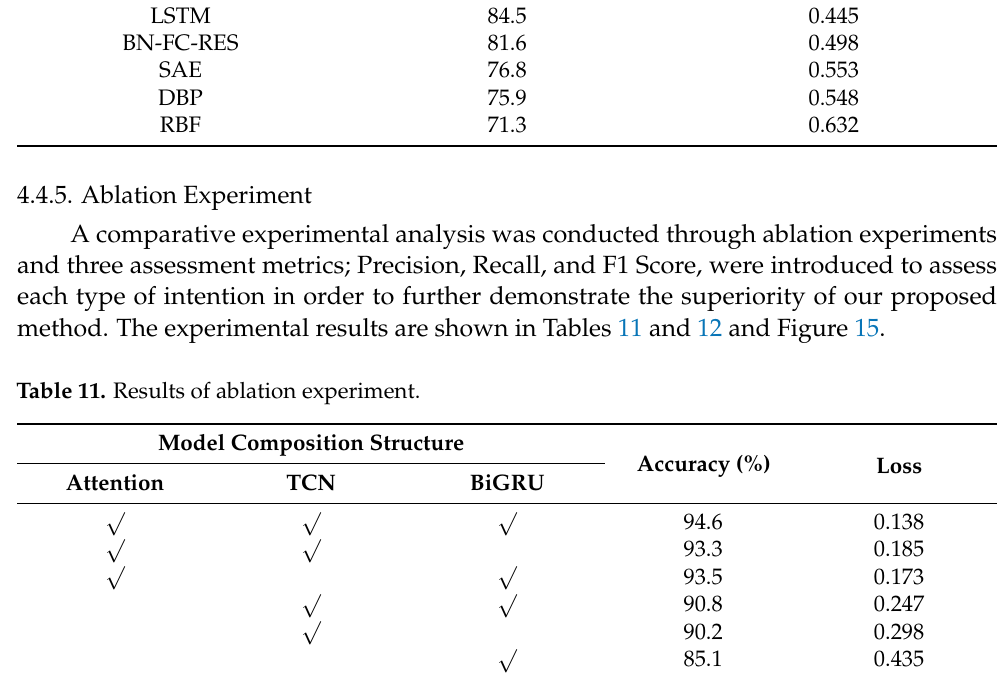
Table 12. Results of evaluation indexes of ablation experiment. 1 (cid:13) , 2 (cid:13) , 3 (cid:13) , 4 (cid:13) , 5 (cid:13) , and 6 (cid:13) respectively represent the Attention- TCN-BiGRU, Attention-TCN, Attention-BiGRU, TCN-BiGRU, TCN, and BiGRU air target intention recognition models.